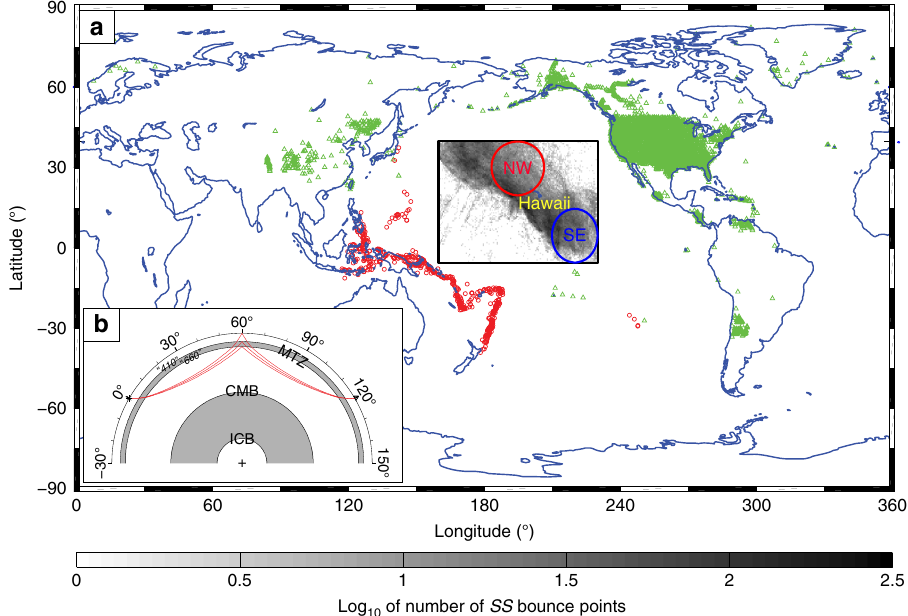
Fig. 1 Study region and ray geometry of SS precursors. a Map showing the study region (black rectangle) and distribution of sources (red circles) and receivers (green triangles) used in this study. The circles within the black rectangle indicate the bins NW and SE of the Hawaiian hotspot for stacks shown in Fig. 4. Gray tones represent the distribution of ~180,000 SS re fl ection points (0.5 ° × 0.5 ° bins; scale bar below map). b Ray geometry of SS , S 410 S , and S 660 S for Δ = 120